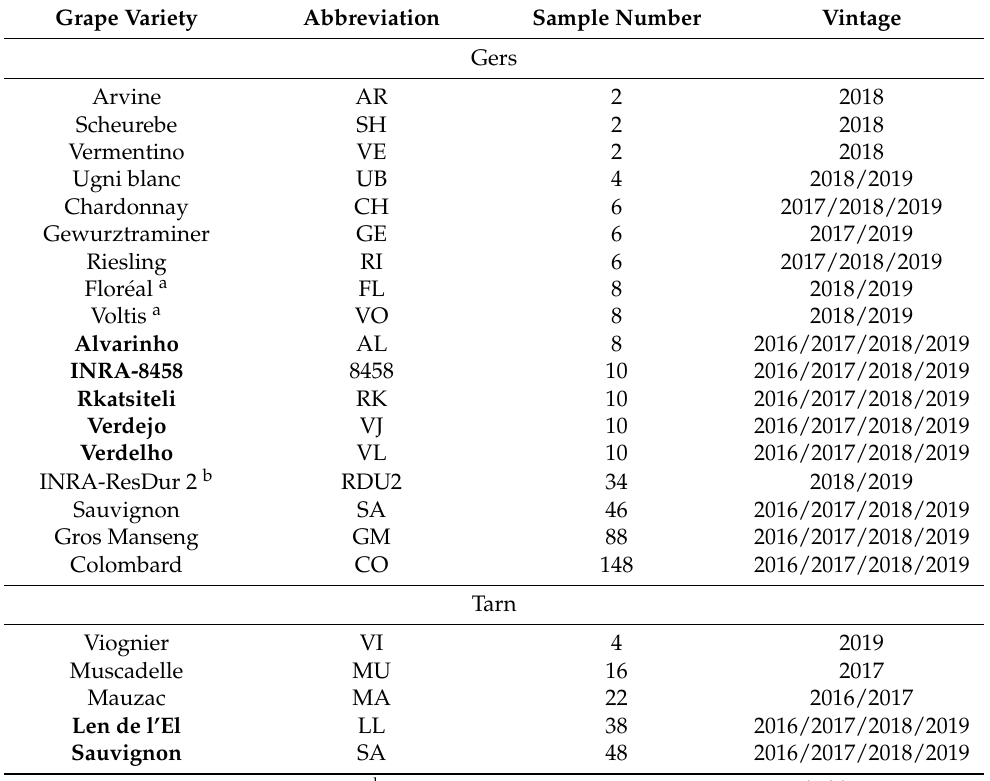
Table 1. Information of musts and wines analyzed in the study (grape varieties, abbreviations, sample number, vintages, and